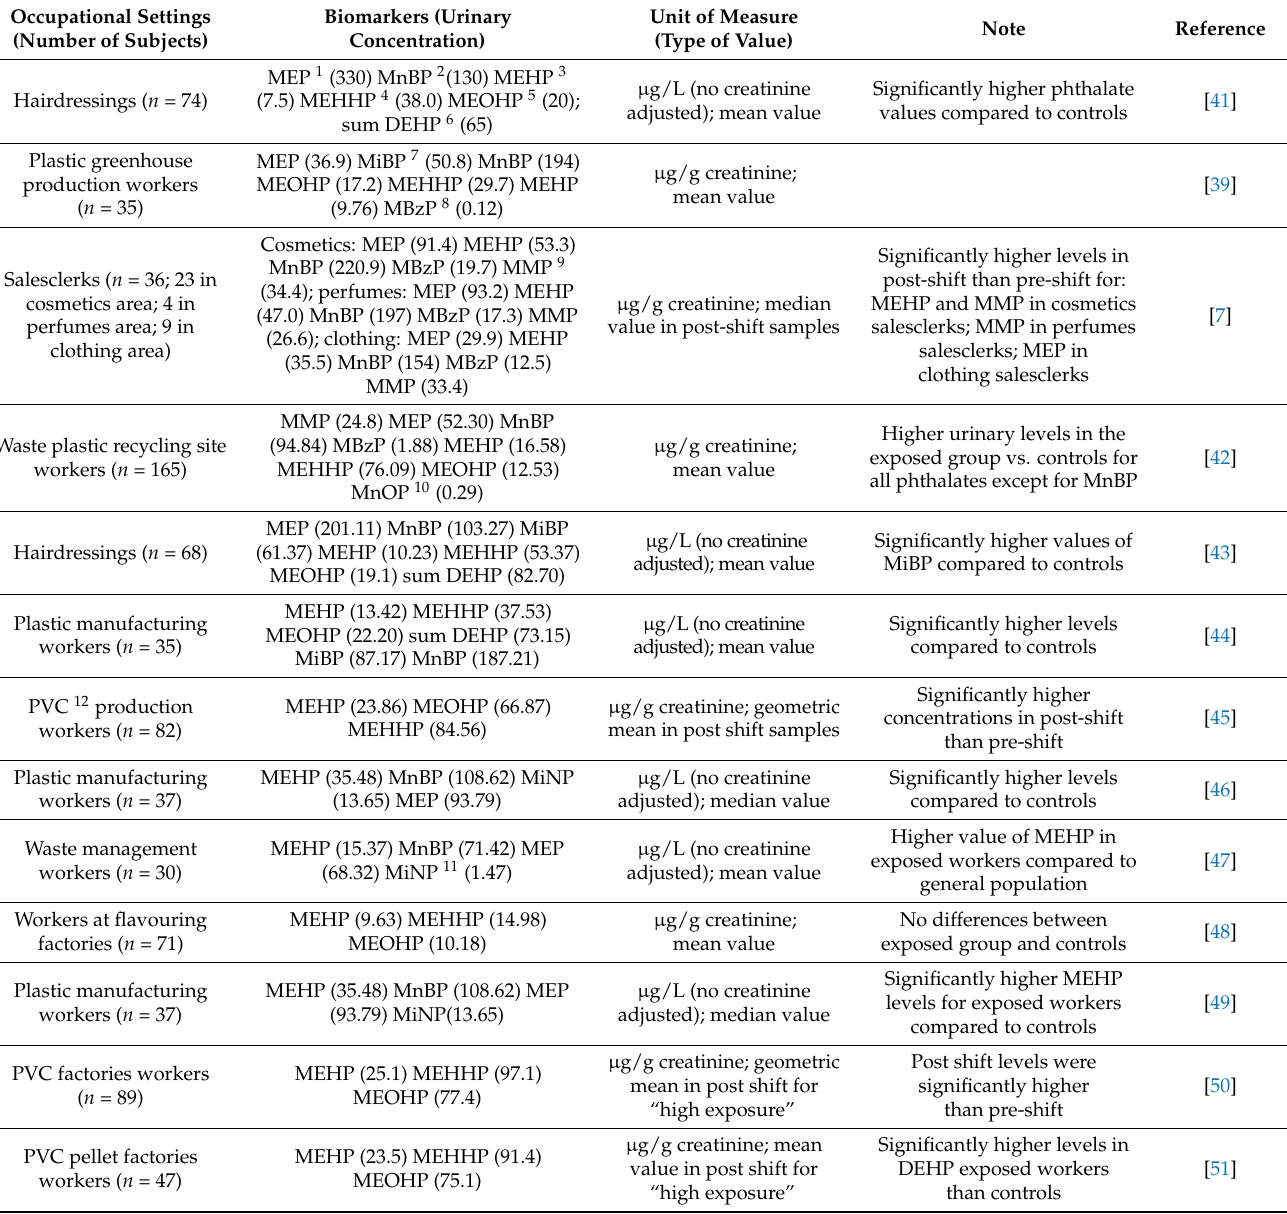
Table 1. Occupational studies on phthalate